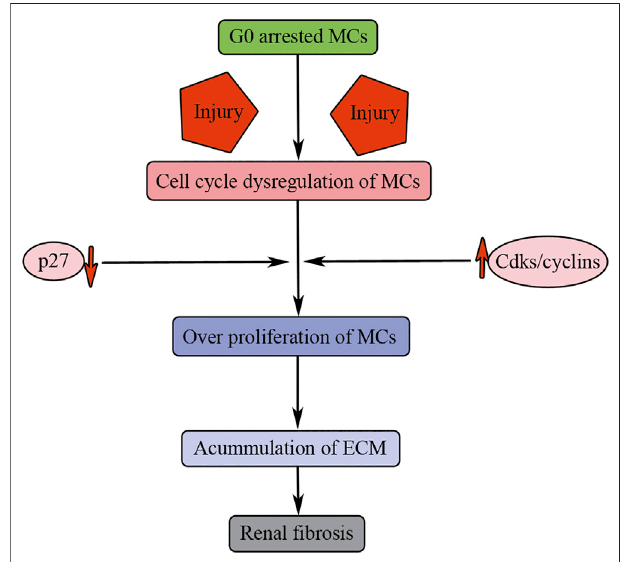
FIGURE 5 | Cell cycle dysregulation of MCs results in renal fi brosis. Injuries result in G0 arrested MC entry into cell cycle. p27 downregulation and Cdks/cyclin upregulation induce overproliferation of MCs, accumulation of ECM, and fi nally causing renal fi